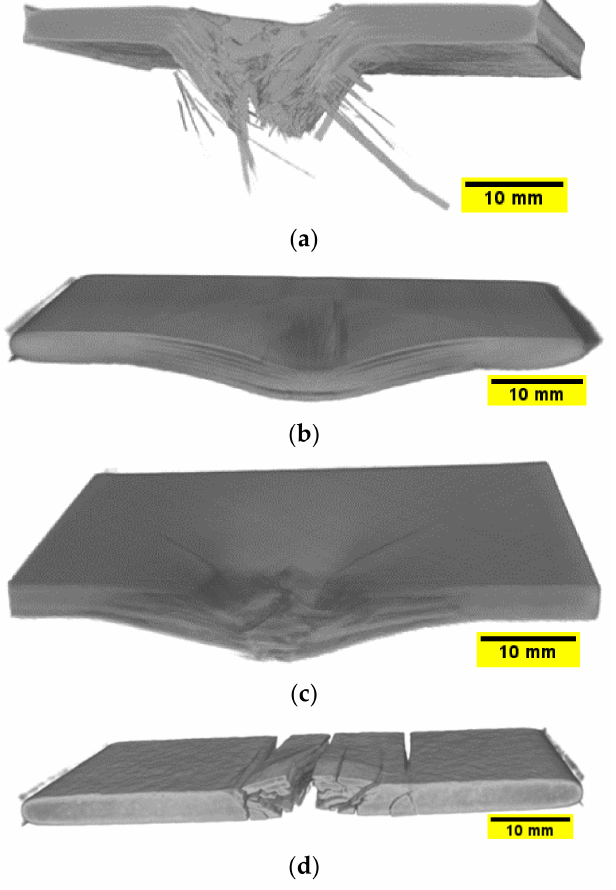
Figure 11. 3D CT scan views of samples after impact using an energy of 225 J ( a ) [ 0/90/ + 45/ − 45 ]